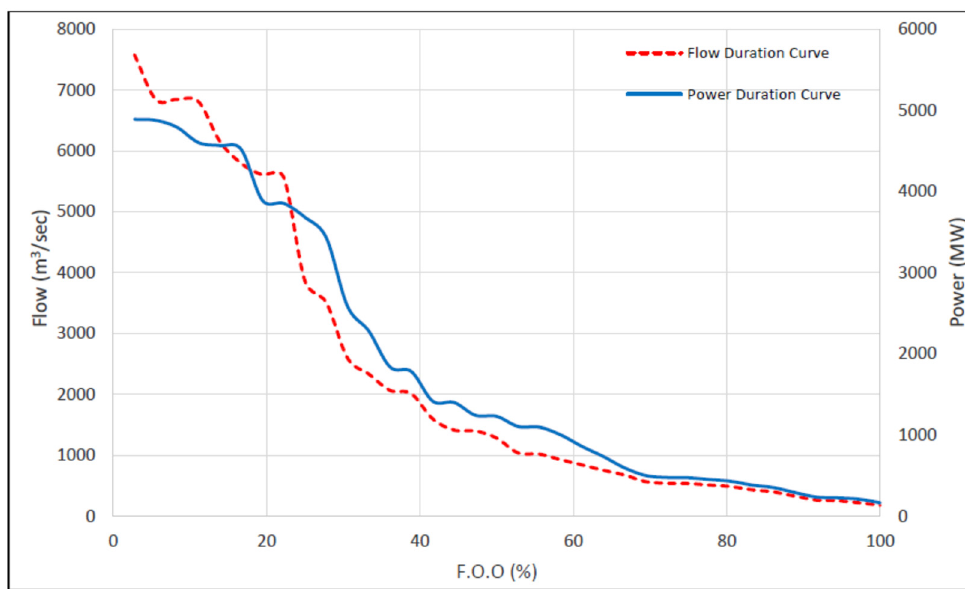
Figure 40. Flow and Power Duration curves of Application year 2030.